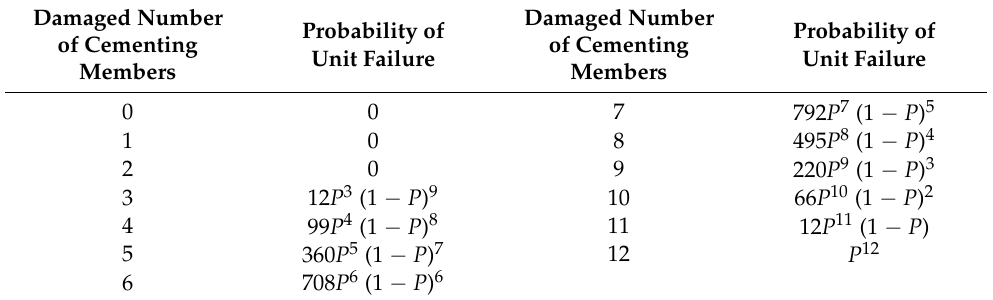
Table 1. Failure probability of a unit under the 13 types of failure conditions for cementing